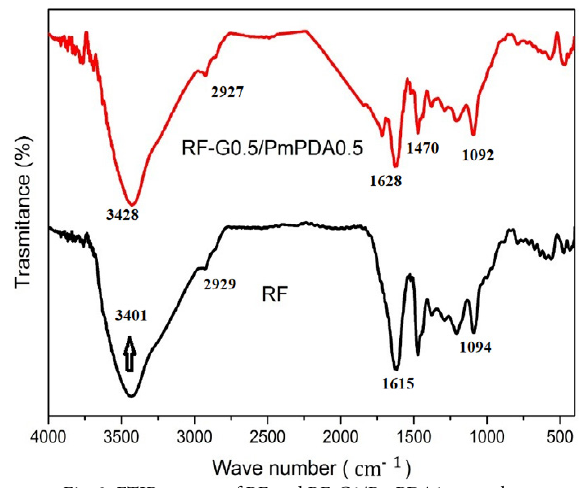
Fig. 2. FTIR spectra of RF and RF-G1/PmPDA1